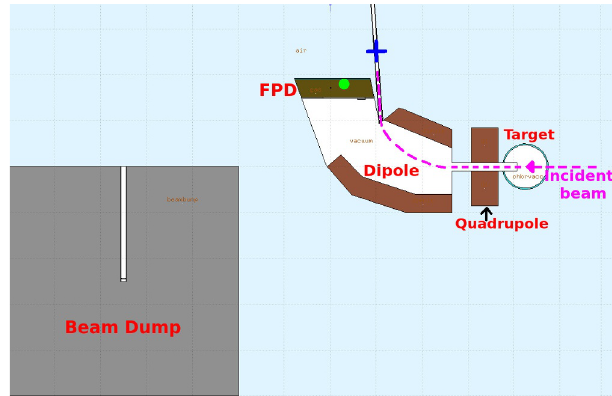
Figure 1. A schematic representation of the expected geometry, after the facility upgrade, at the MAGNEX experimental appara- tus considered in the FLUKA simulations. The detector used in the simulation is indicated by a filled green circle, while the po- sition where the 10W loss occurs is denoted with the blue cross (see text for